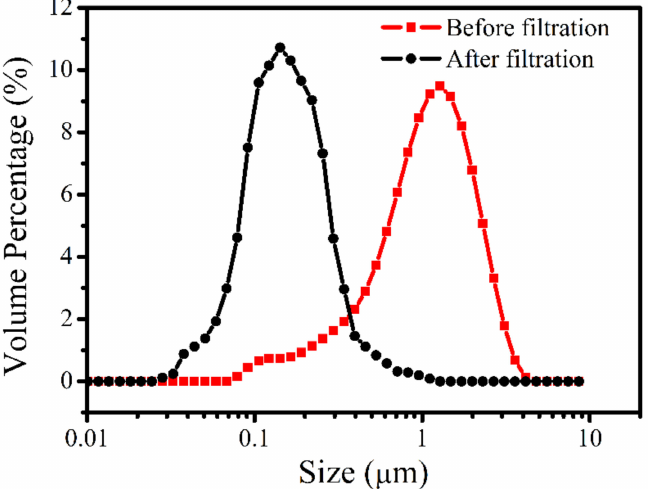
Figure 8. Oil droplets size distributions of the prepared oil-in-water emulsion before and after filtration at 0.1 MPa, 2.5 L/min.